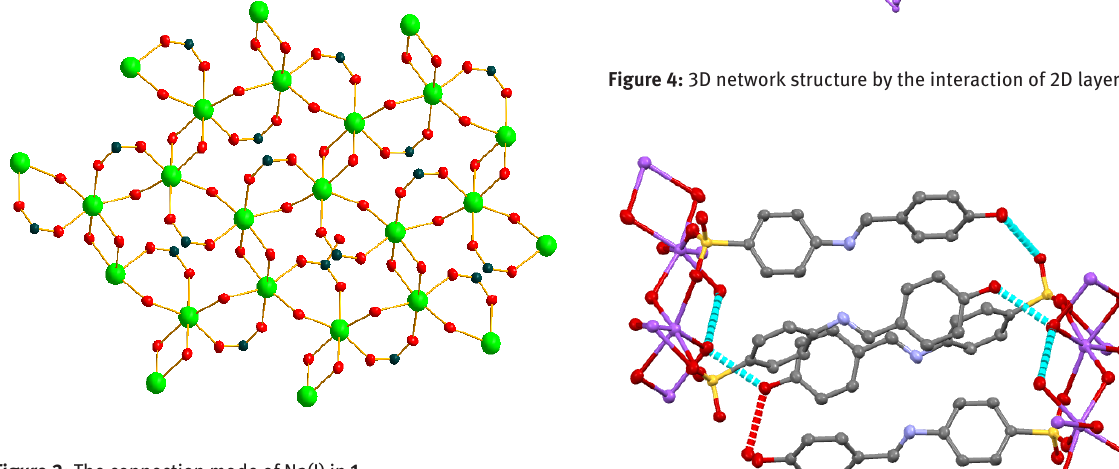
Figure 2: The connection mode of Na(I) in 1 .